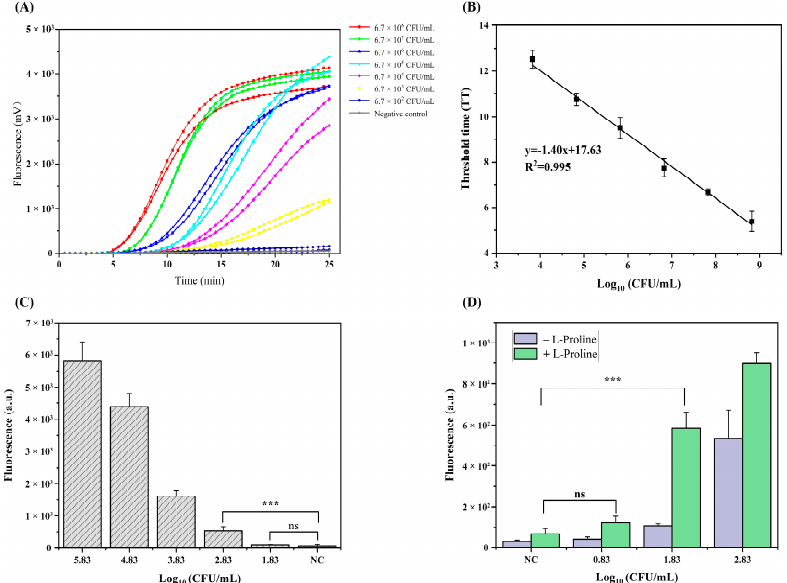
Figure 5. LOD results of different methods, for ten-fold serial dilutions of V. parahaemolyticus in pure culture: qRAA ( A ), RAA–CRISPR ( C ), and CE–RAA–CRISPR ( D ). ( B ) Linear relationship between fluorescence intensity and the concentration of V. parahaemolyticus over the range of 6.7 × 10 3 to 6.7 × 10 8 CFU/mL. *** indicated a statistically significant difference, p < 0.001; ns indicates no significant difference.